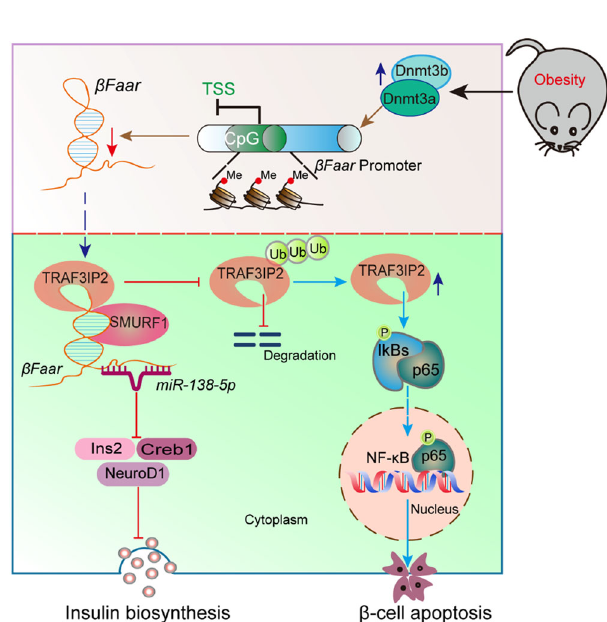
Fig. 8 Schematic illustration for the mechanism of obesity-induced reduction of β Faar impairing insulin biosynthesis and exacerbated β -cells apoptosis. During obesity, β Faar is downregulated by DNA hypermethylation, suppressing insulin biosynthesis and secretion by downregulating islet-speci fi c gene ( Ins2, NeuroD1, and Creb1 ) expression through sponging miR-138-5p . Moreover, reduced β Faar inhibits to recruit E3 ubiquitin ligase SMURF1, then suppressing the ubiquitination and degradation of TRAF3IP2, activing the NF- κ B signal pathway, and fi nally inducing β -cell